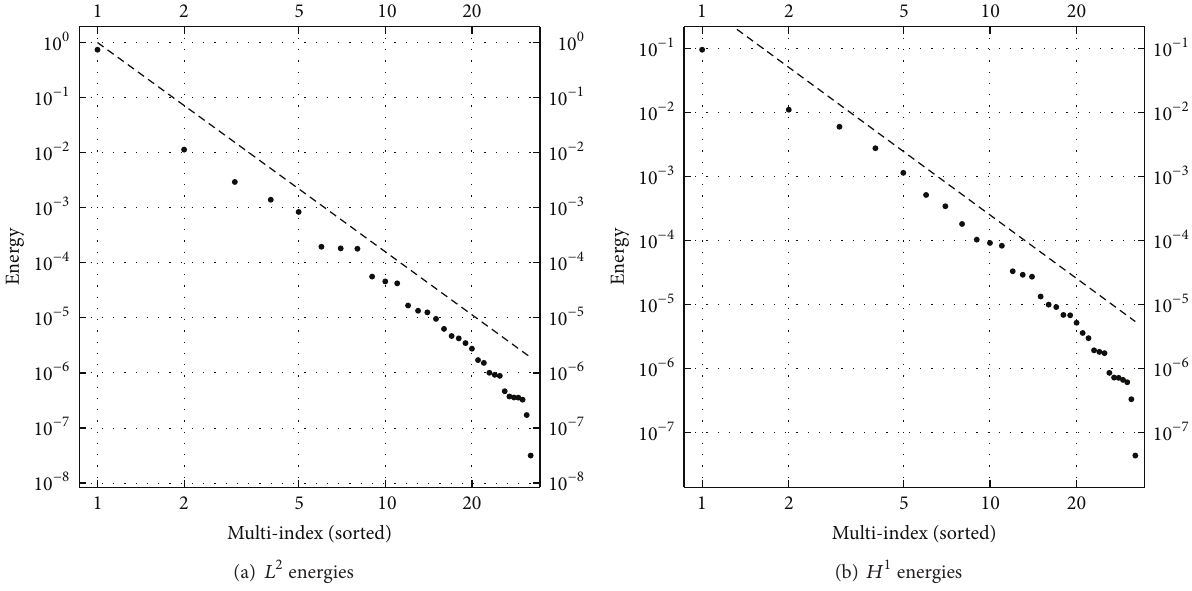
Figure 6: Case B: energies of the spectral components { u 𝛼 } 𝛼∈ A algebraic convergence rates of − 3.8 and − 3.3 for the 𝐿 2 norm and 𝐻 1 seminorm, respectively. Plotmarkers: sorted means of the energies in